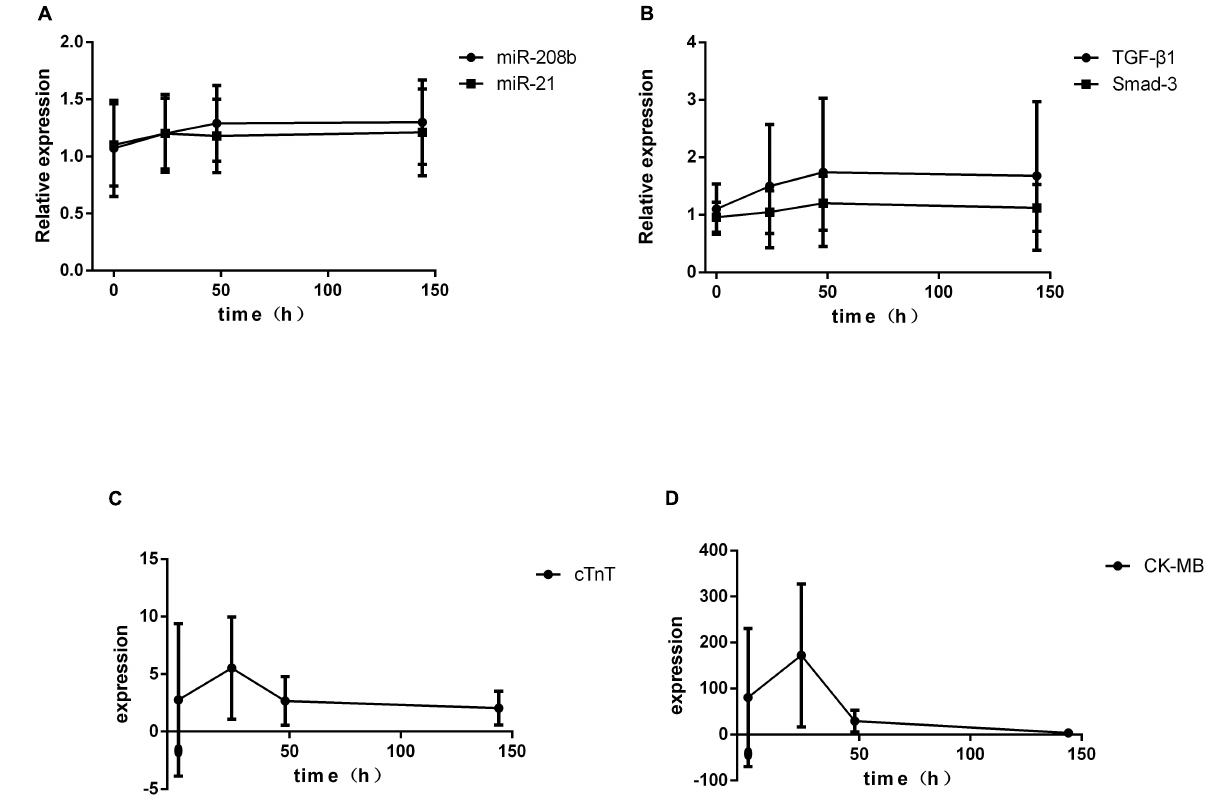
( P < 0.01). The expression level of TGF- β 1 was